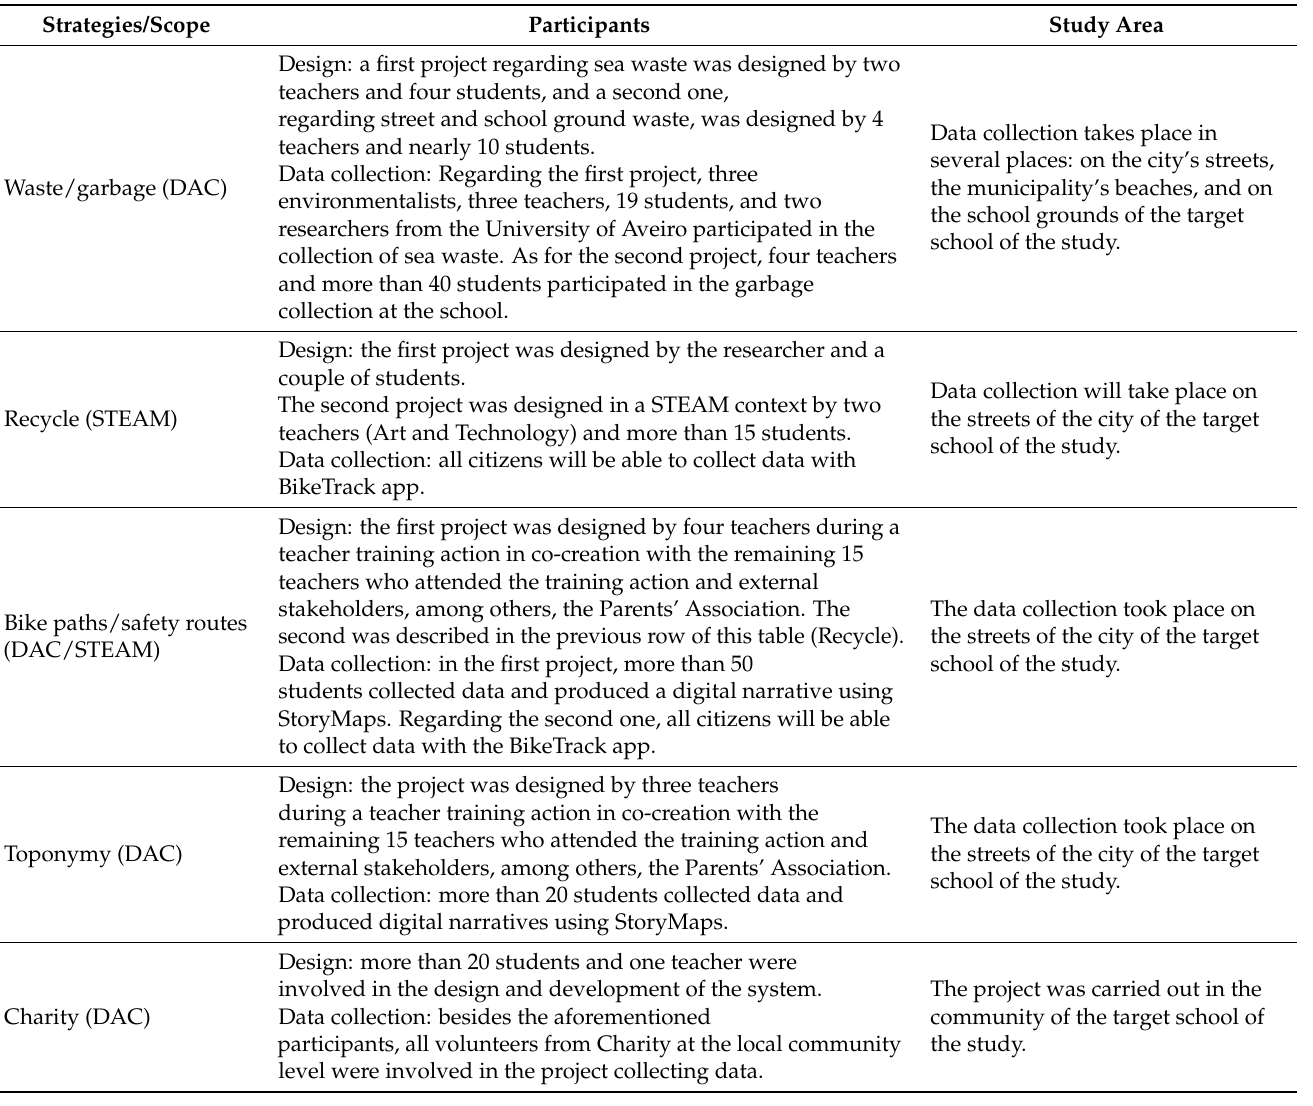
Table 8. Citizen sciences strategies—citizens’ engagement in data collection.